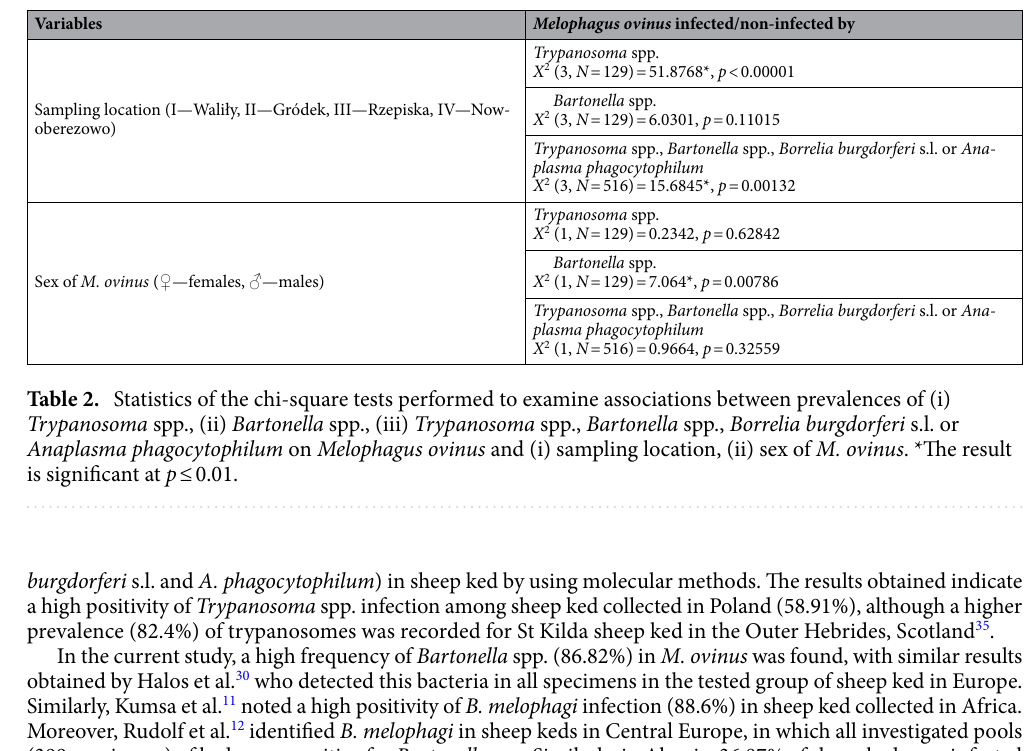
Sampling location (I—Waliły, II—Gródek, III—Rzepiska, IV—Now-